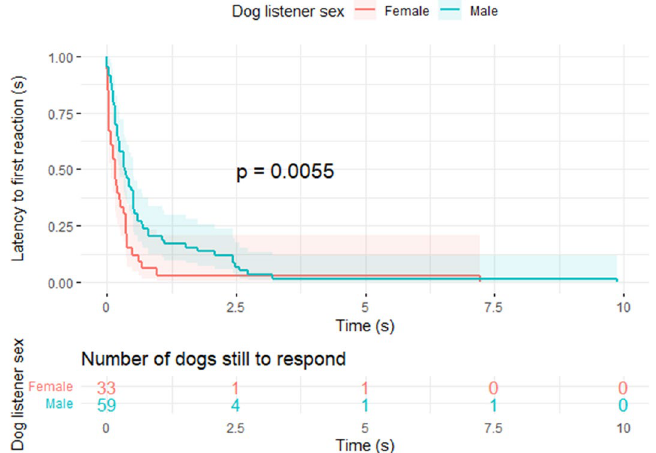
Figure 1. Survivorship plot for latency to first attention for male and female dogs, with time in seconds, p = 0.006. The survivorship plot maps how long it takes to reach a completed response (or time for the trial elapses) and compares this across factors. Male dogs have a longer latency to react than female dogs.